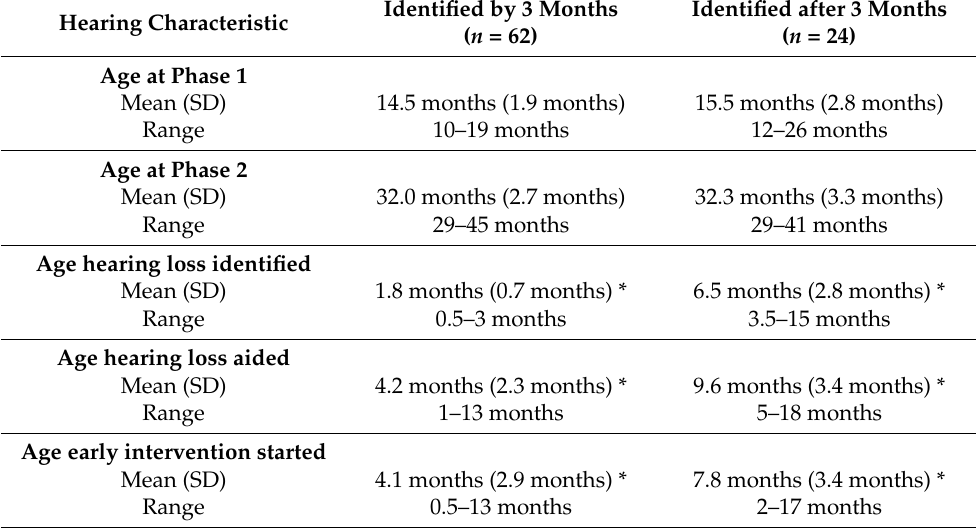
Table 3. Age and hearing characteristics for participants with hearing loss identified by 3 months and participants with hearing loss identified after 3